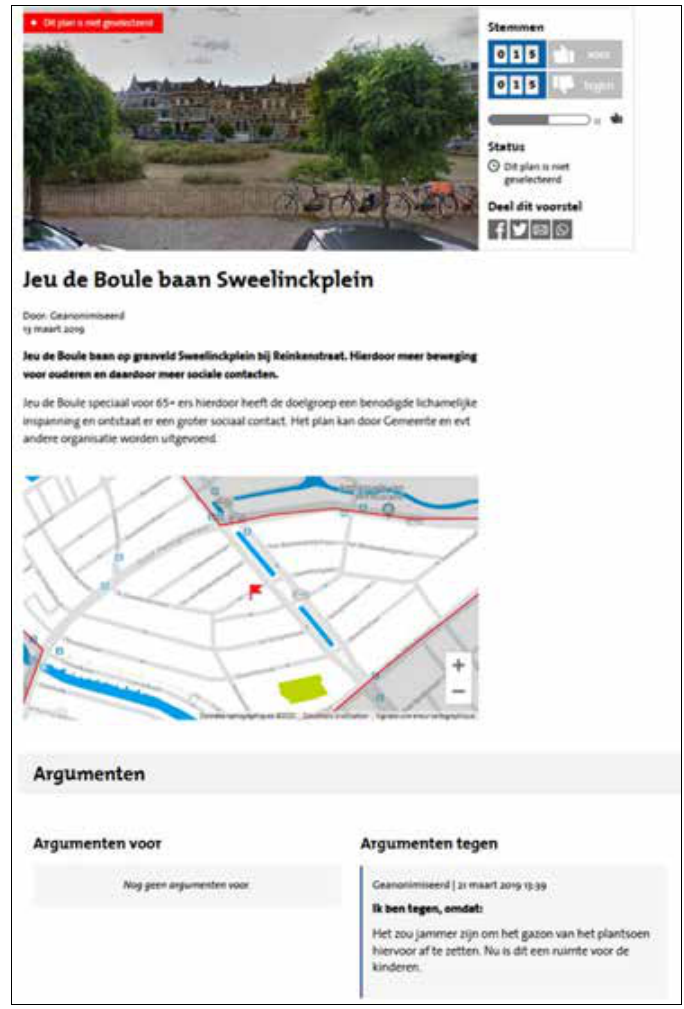
Figure 1: Example of an online proposal (archived version). Source: Retrieved from